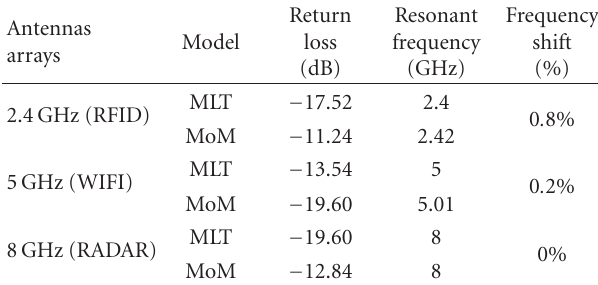
Figure 18: Bow-tie antenna array VSWR. Table 1: Comparison between transmission line model and method of